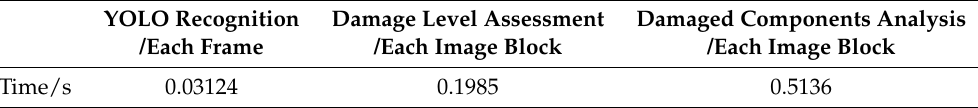
Table 3. Time consumption for each stage of YOLO-VGGNet damage